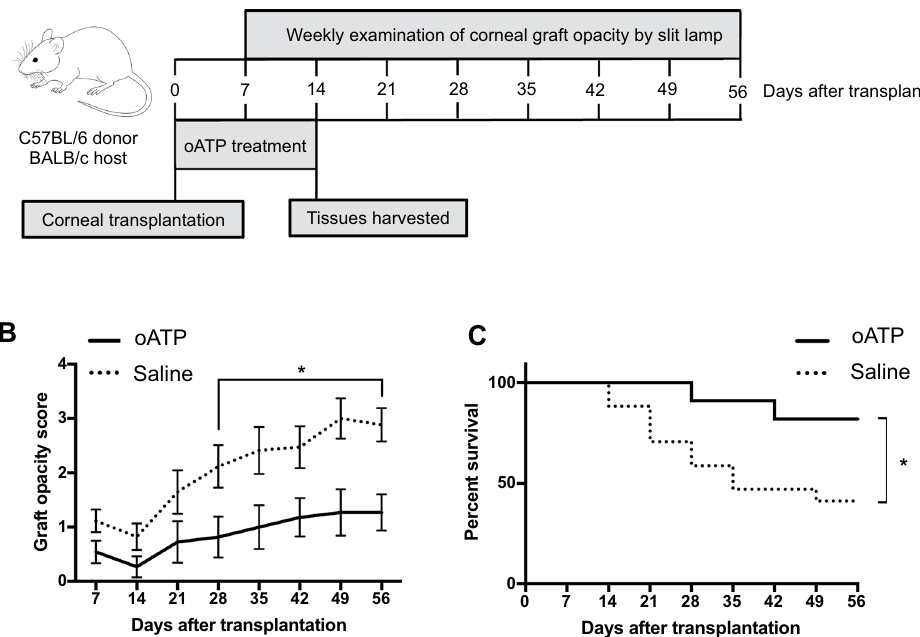
Figure 4. Treatment with oATP decreases graft opacity and promotes corneal allograft survival. Allogeneic corneal transplantation was performed and oATP (10 μ g/g mouse body weight) or saline (control) were administered via intraperitoneal injection once daily for 14 days starting from the day of transplantation. Graft opacity was evaluated for eight weeks following transplantation, and graft survival was determined according to an established scoring system. (A) Schematic diagram depicting the time points of slit lamp examination of corneal graft opacity. ( B ) Graft opacity scores were significantly decreased in the oATP-treated group from week 4 until week 8 (p < 0.05). (C) Kaplan-Meier survival curve of oATP-treated graft recipients vs. saline- treated controls. Logrank test demonstrates significantly improved survival in the oATP-treated group relative to control (p = 0.032). Data shown is pooled from two independent experiments (n = 6–10/group). Data is represented as mean ±